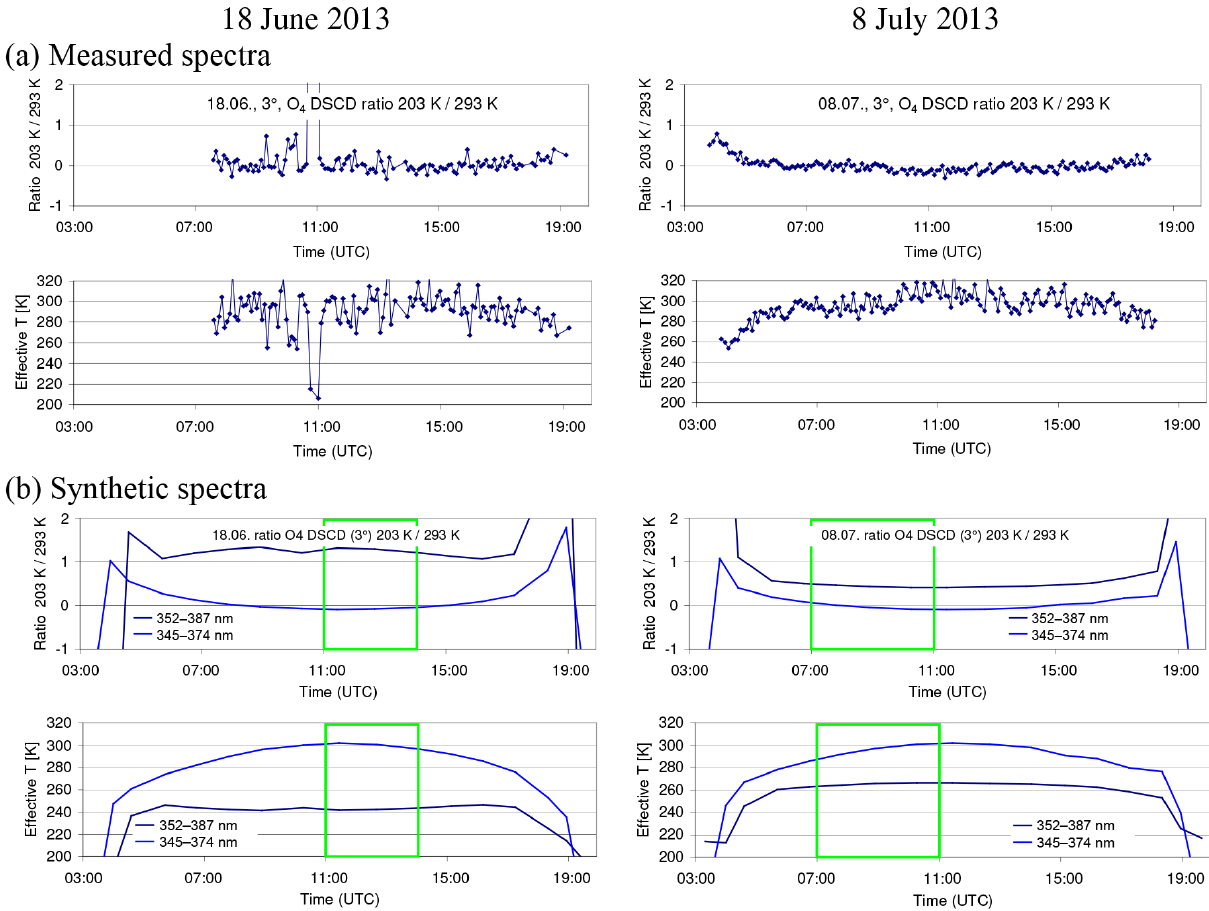
Figure A28. Ratios of the retrieved O 4 dSCDs for 203 and 293K as well as the derived effective temperatures for the analyses with both cross sections